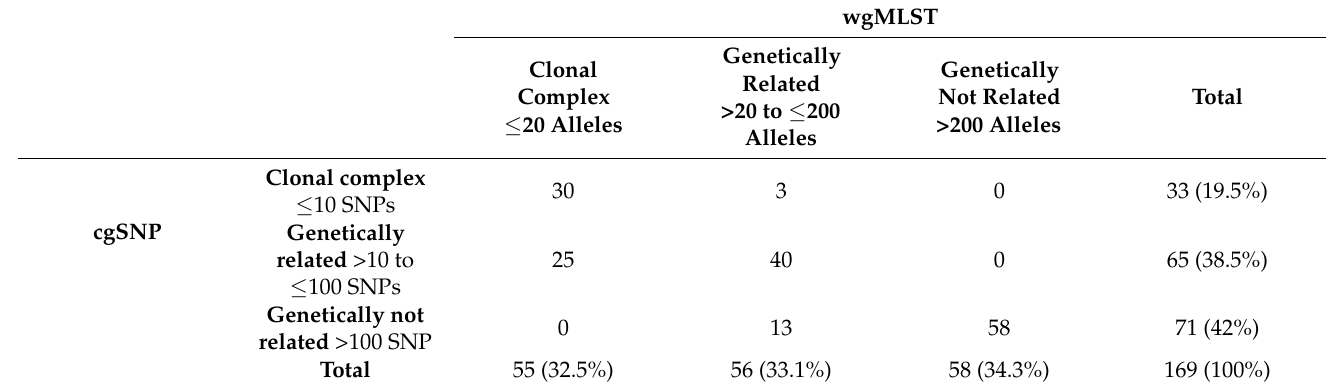
Table 1. Comparison of the genetic links between wgMLST and cgSNP analyses (n = 169 patients). wgMLST Genetically Clonal Related Complex ≤ 20 Alleles